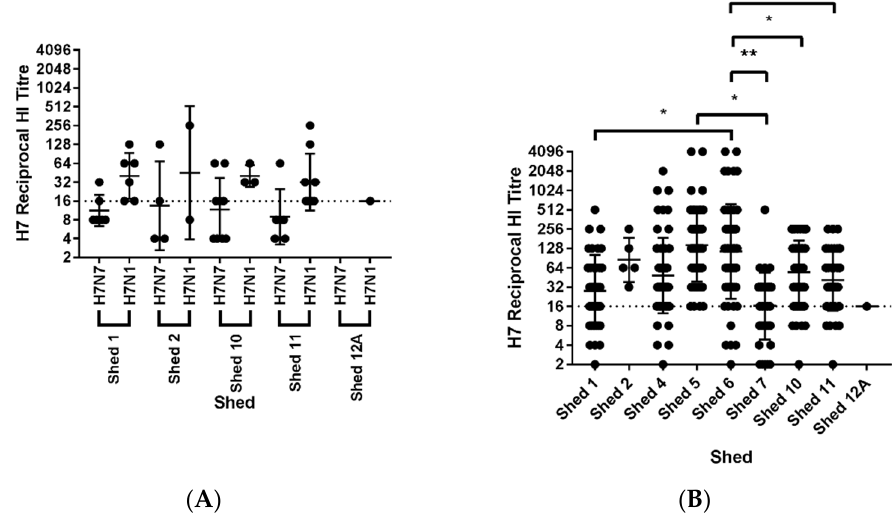
Figure 5. Antibodies towards H7 AIV were found in chickens from the IP. Sera in ( A ) Sample Set 2 and ( B ) Sample Set 3 collected from chickens at the IP were tested by HI assay. The total number of sera tested from each shed is provided in Table 5 (Sample Set 2) and Table 6 (Samples Set 3). The sera in Sample Set 2 were tested against the H7N7 and H7N1 primary and secondary AIV antigens, whereas sera from Sample Set 3 were tested against the H7N1 AIV antigen only. Graphs show geometric mean ± geometric SD. The reciprocal HI titers were compared between antigens and sheds using a One-Way ANOVA for all samples. * p < 0.05, ** p < 0.01.